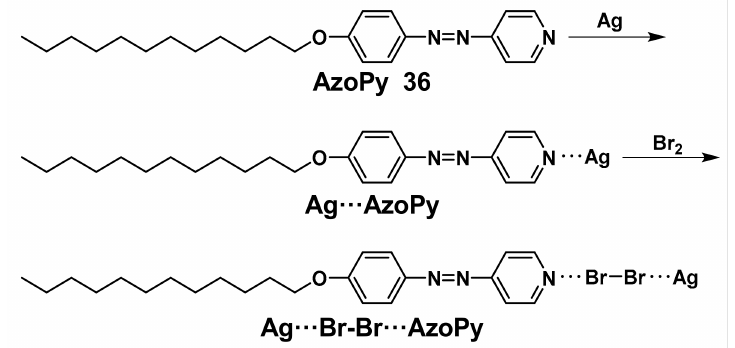
Figure 18. The molecular structure of azopyridine complex 36 .